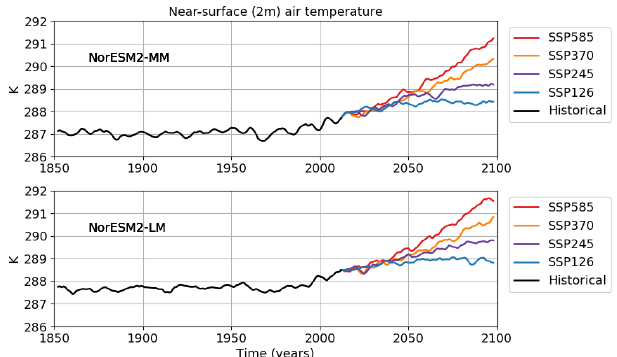
Figure 5. Time evolution of globally averaged surface air tempera- ture in NorESM2-MM and NorESM2-LM from the historical sim- ulations (black lines) and CMIP6 scenario experiments SSP1-2.6, SSP2-4.5, SSP3-7.0, and SSP5-8.5 (coloured lines). A 5-year mov- ing average is used.